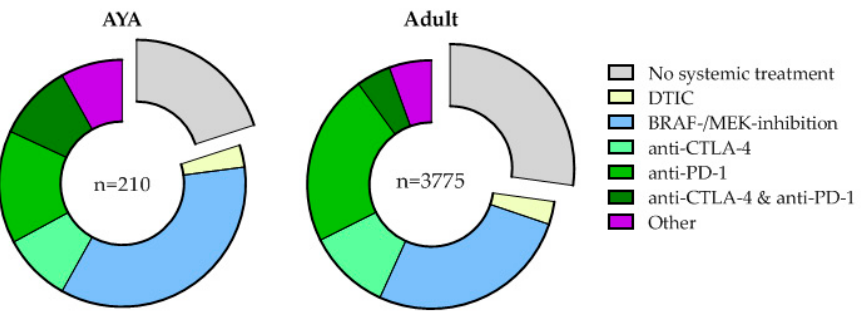
Figure 3. First-line melanoma treatment initiated in Adolescents and Young Adults (AYA) and older adults (Adult).